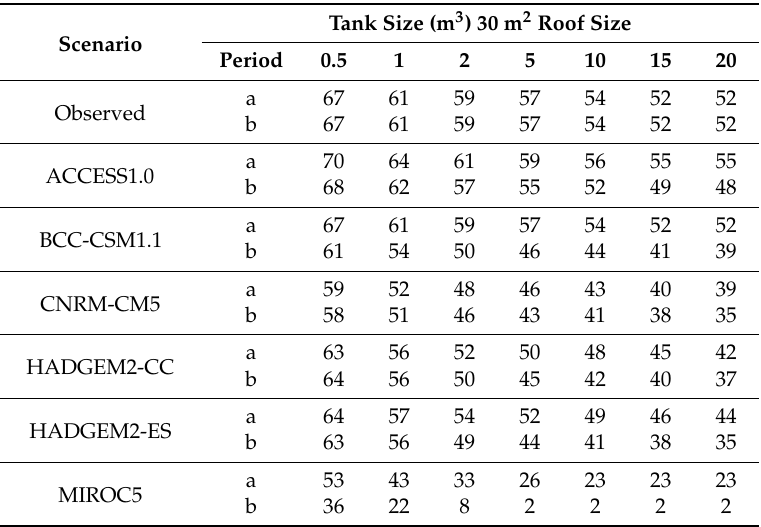
Table 8. Observed and projected water security for JJA dry season.